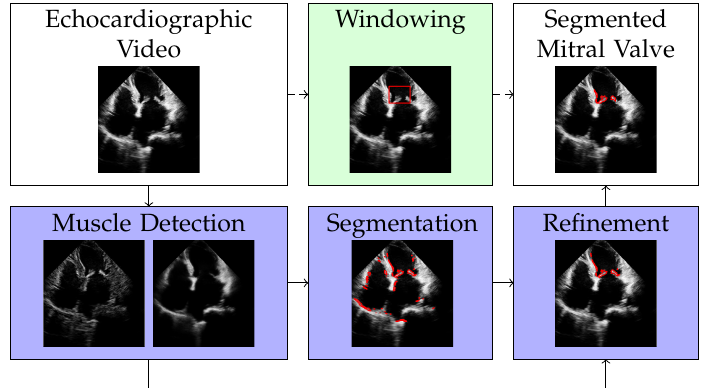
Figure 1. Overview of the proposed method. The white filling of the box shows the input and output of our method. The dark purple fill shows the mandatory steps, while the light green fill indicates the optional step of our